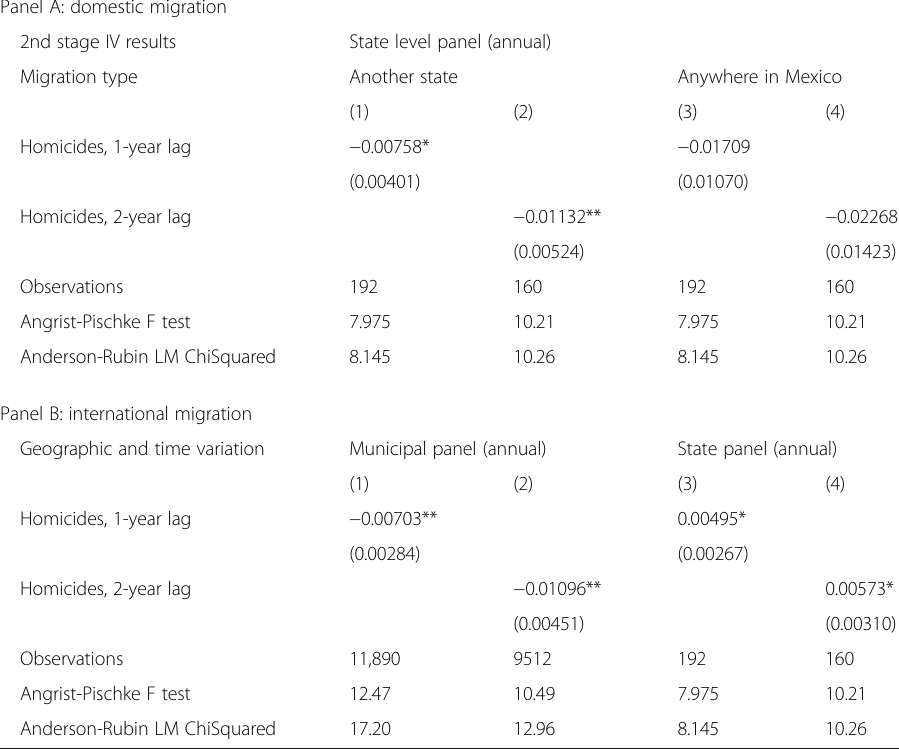
Table 8 Robustness checks: lagged crime and migration patterns Panel A: domestic